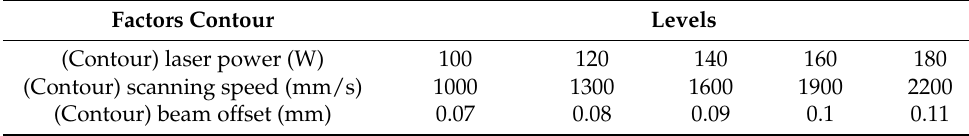
Table 3. Factor levels of L 25 (5 3 ) orthogonal test.